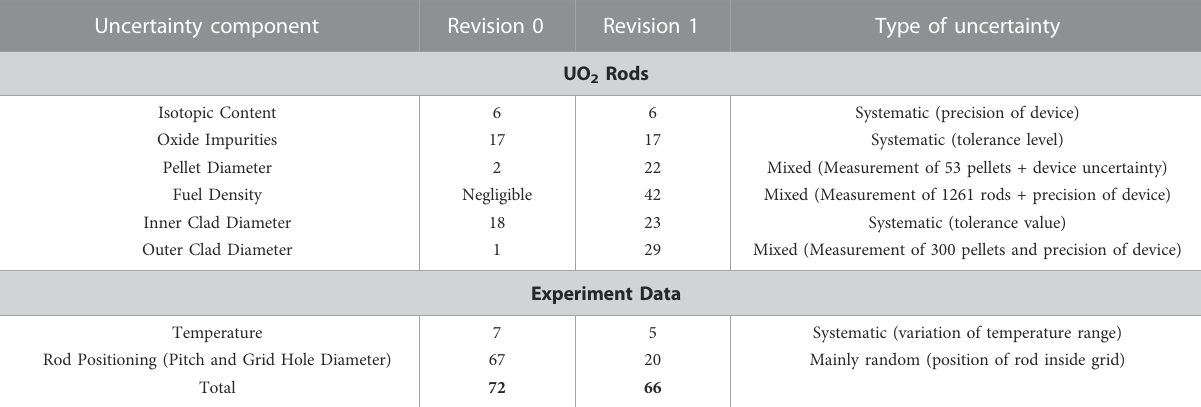
TABLE 2 Evaluated Experimental 1 σ Uncertainties (in pcm) for LEU-COMP-THERM-071 Experiments.